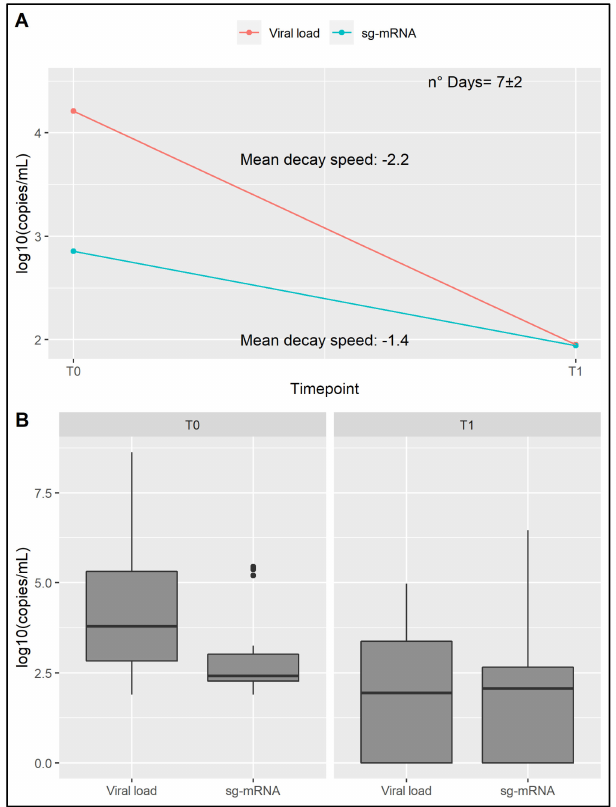
Figure 4. Assessment of sg-RNA component. ( A ) Representation of the sg-RNA concentration and corresponding viral load decay over time. ( B ) sg-RNA concentration and corresponding viral load reported for the deemed timepoints. Both sg-RNA concentration and viral load are reported in log 10